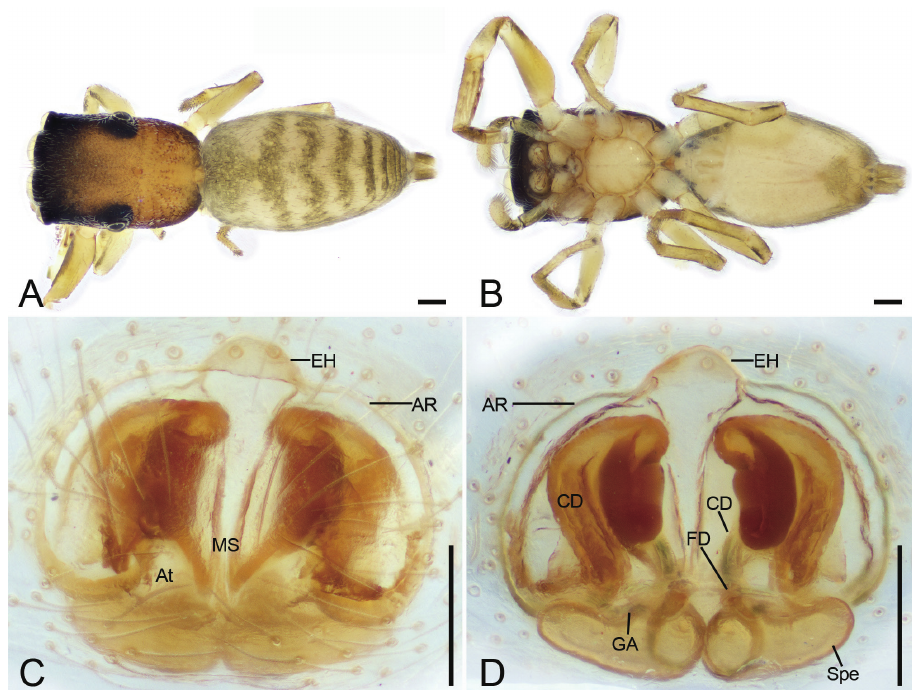
Figure 8. Synagelides serratus sp. nov., female paratype A habitus, dorsal view B same, ventral view C epigyne, ventral view D same, dorsal view. Abbreviations: AR – atrial rim, At – atrium, CD – copula- tory duct, CO – copulatory opening, EH – epigynal hood, FD – fertilization duct, GA – glandular ap- pendages, MS – median septum, Spe – spermatheca. Scale bars: 0.2 mm ( A, B ); 0.05 mm ( C, D